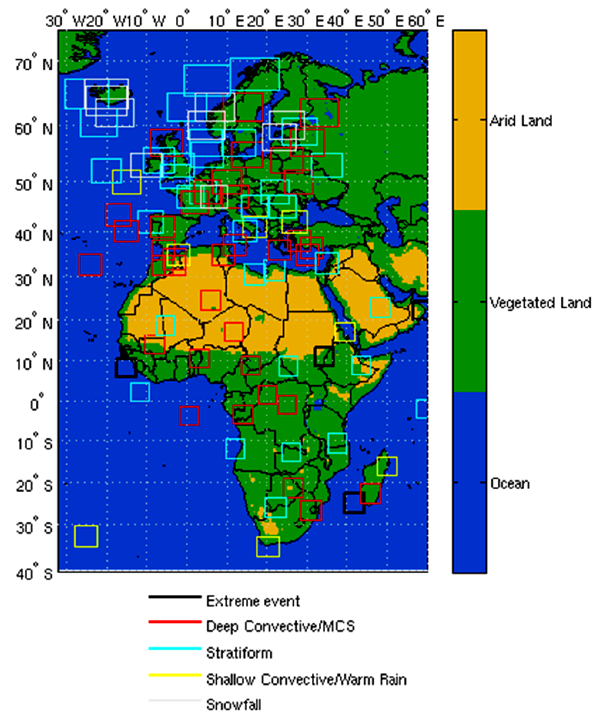
Figure 1. Geographical location of the inner domain of the 94 NMS simulations over European and African